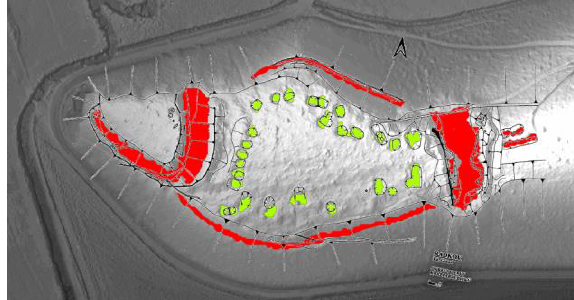
Figure 10. Radkov – georeferenced raster and polygons